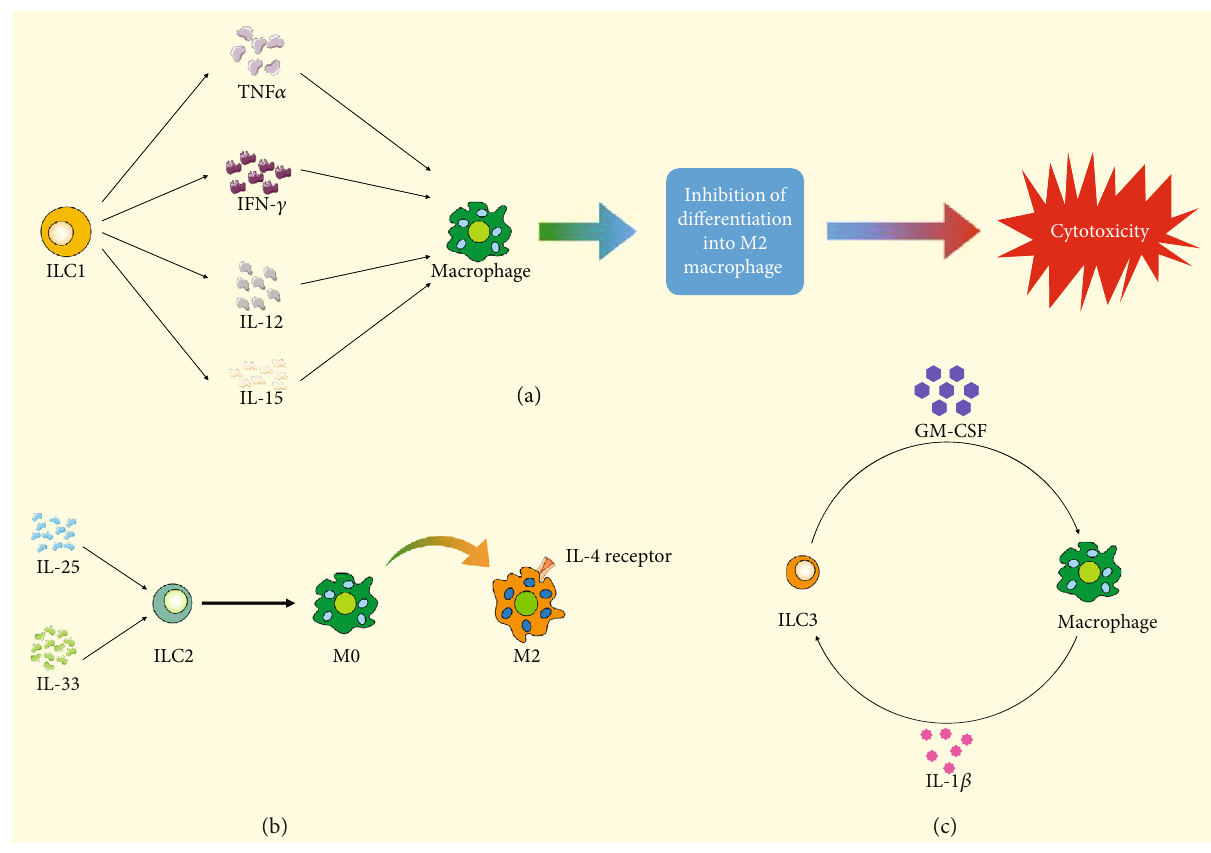
Figure 3: Illustration of interactions of macrophages and di ff erent ILCs. (a) TNF- α , IFN- γ , IL-12, and IL-15 released from ILC1 stimulate macrophage di ff erentiating into cytotoxic macrophage and inhibit di ff erentiation into M2 macrophage di ff erentiation. (b) After being stimulated by IL-25 and IL-33, ILC2 promotes the transformation of M2 macrophage from M0 macrophage. (c) The crosstalk of ILC3 and macrophage is mainly induced by GM-CSF and IL-1 β . ILC: innate lymphoid cell; TNF: tumor necrosis factor; IL: interleukin; M0: M0 macrophage; M2: M2 macrophage; GM-CSF: granulocyte-macrophage colony stimulating